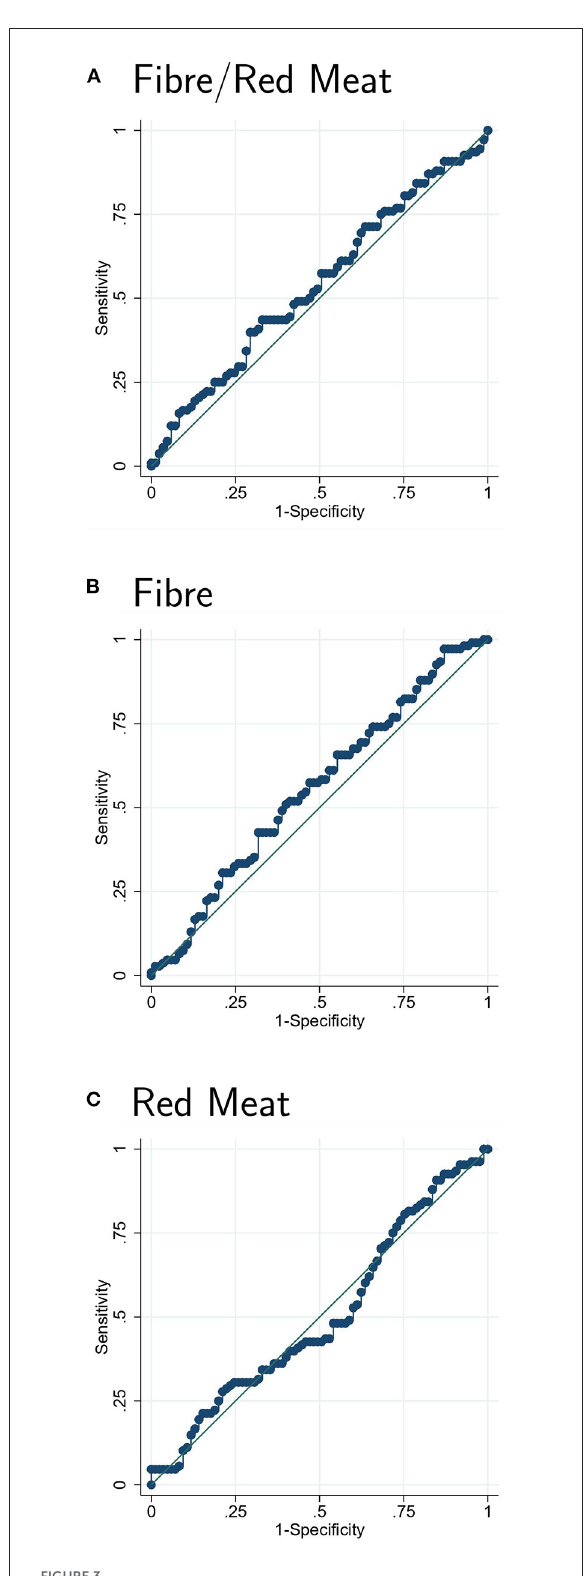
FIGURE3 Receiver operating characteristics curve analysis for the predictive value of the ratio of fibre and red/processed meat